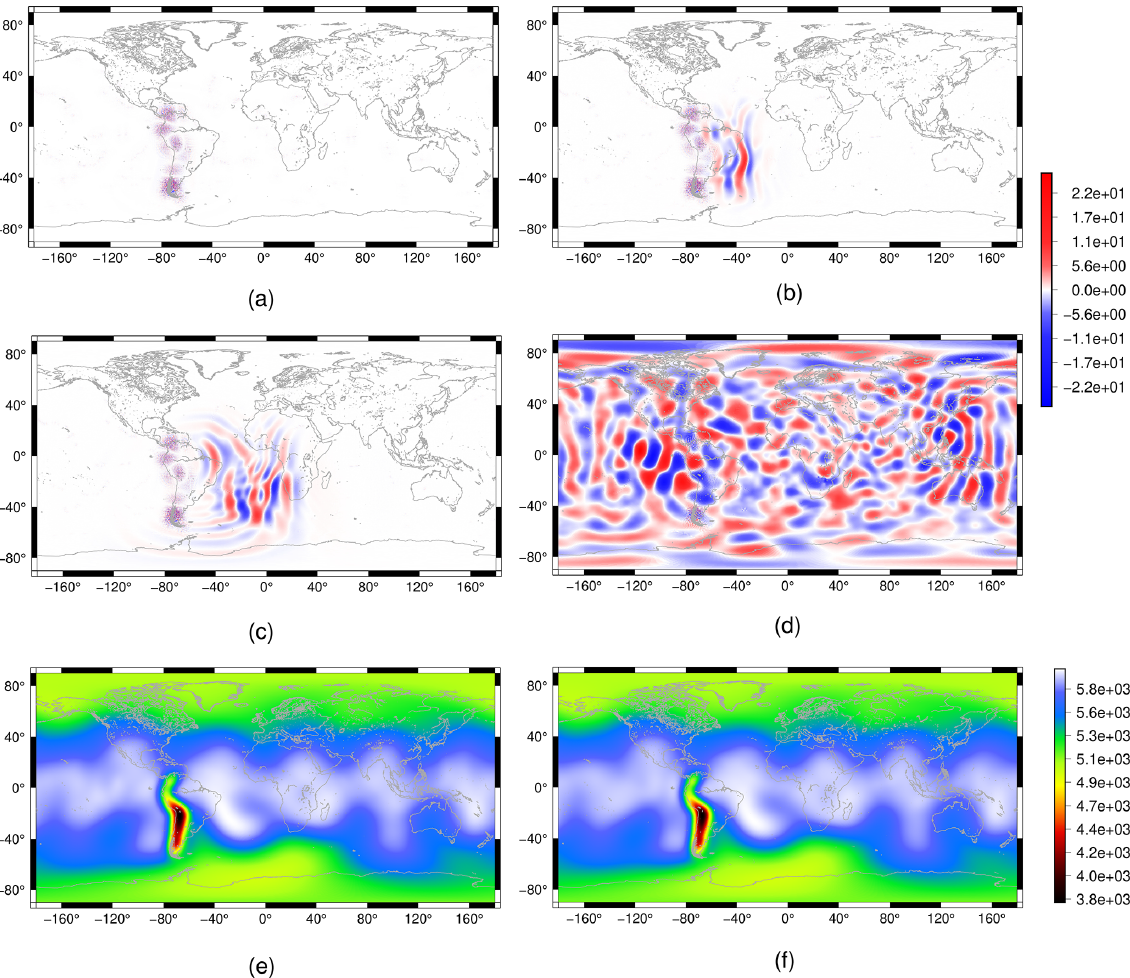
Figure 12. Flow over the Andes test case for the shallow-water model: height field cell-wise error plots for the VR7 grid after 1h (a) , 2d (b) , 3d (c) and 30d (d) . We consider the ENDGame solution as a reference solution. We show the height field for the VR7 grid in (e) and the reference height field (f) after